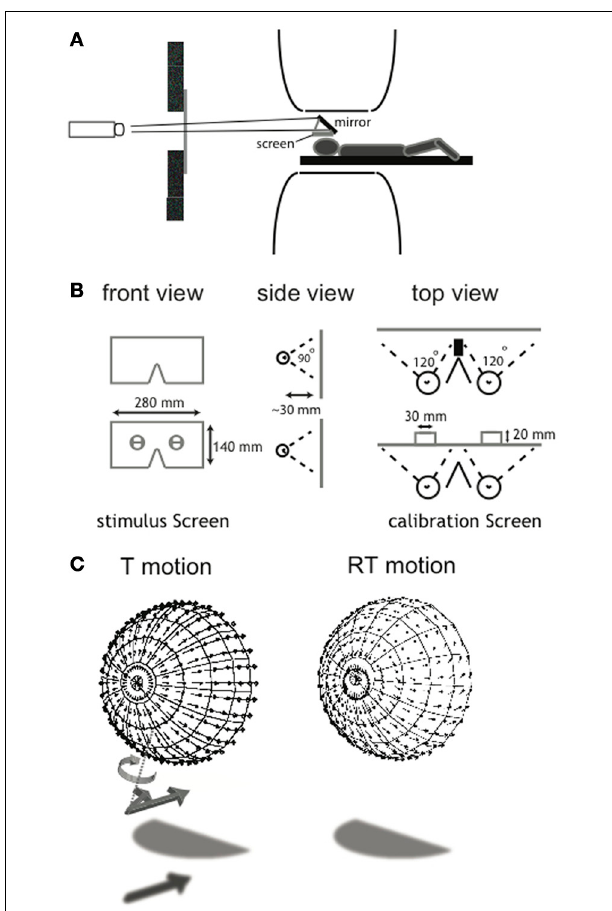
FIGURE 1 | Illustration of the wide-field visual projection set-up and the calibration procedure. (A) A projector with a custom set of lenses projected a small projection over 4.5m distance via a mirror on the projection screen (28 × 14cm). Subjects wore contact lenses with high diffraction ( > 25 diopters) in both eyes and looked at a stimulus screen that was placed ∼ 3cm above the subject’s eyes. The set-up allowed for a stimulus presentation with a field of view of ∼ 110 × ∼ 100 ◦ . (B) To assess the exact eye position relative to the screen, a calibration screen was used. It contained a hole in front of each eye, offering a view on two vertical and one horizontal target, drawn on an opaque board 2cm behind the projection screen. For each eye, subjects aligned three projected lines with the drawn lines on the board. From this, the position of the rotation center of each eye could be derived, which was used for the correct projection of the flow scene (for a detailed description of the calibration procedure, see Supplementary Material). (C) Each panel shows the projection of the 3D cloud of dots, received by the observer as a flow-field here projected on a hemisphere concentric with the head. For clarity, in this figure the projected points were located on a regular grid of visual directions, but in the actual stimuli the points were in random visual directions about the head. The ensemble of motion vectors of individual elements of the flow scene depict T (left) and RT (right) motion. A perturbation of the projected motion vector’s direction in 3D was introduced in the noise conditions ( N 30 , N 60 ). The vector was rotated about an axis (T motion, dotted line) perpendicular to the tangent plane to the sphere as illustrated for the unperturbed vector (arrow with shadow) into the perurbed vector (arrow without shadow). The same perturbation was applied to RT flow but is not drawn here. This implies that component of motion toward the head was unaffected. Direction and magnitude of the rotation were randomly chosen for each element of the